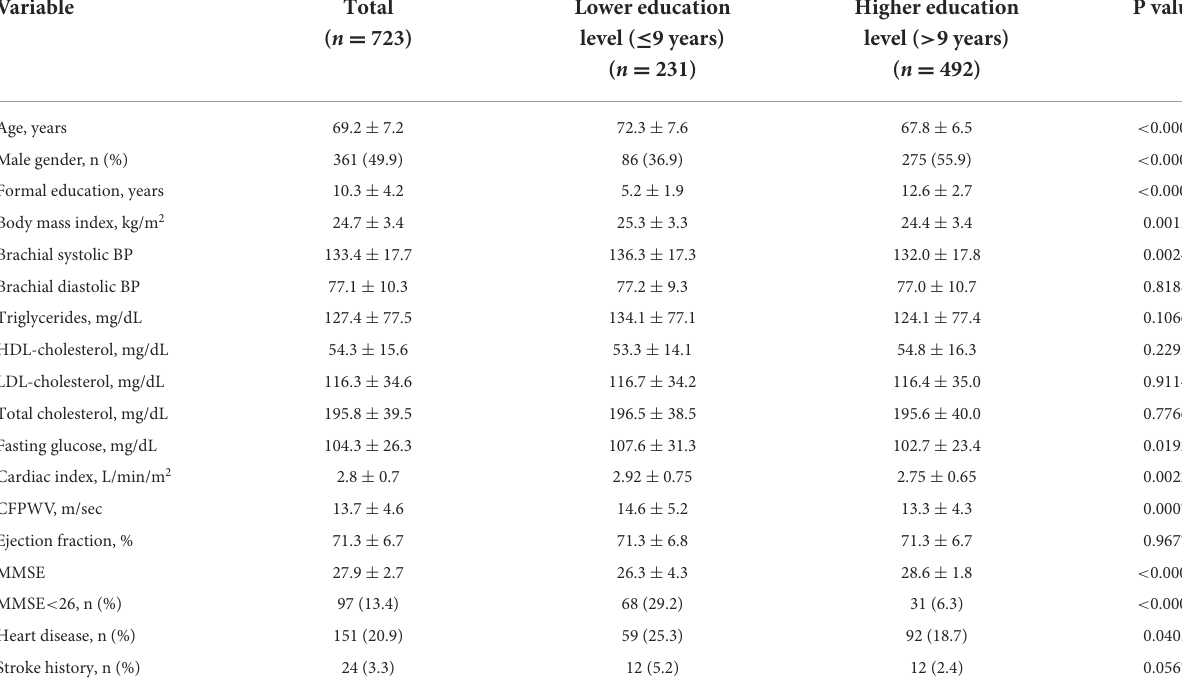
TABLE 1 Characteristics of the study population with lower and higher levels of education ( n = 723). Variable